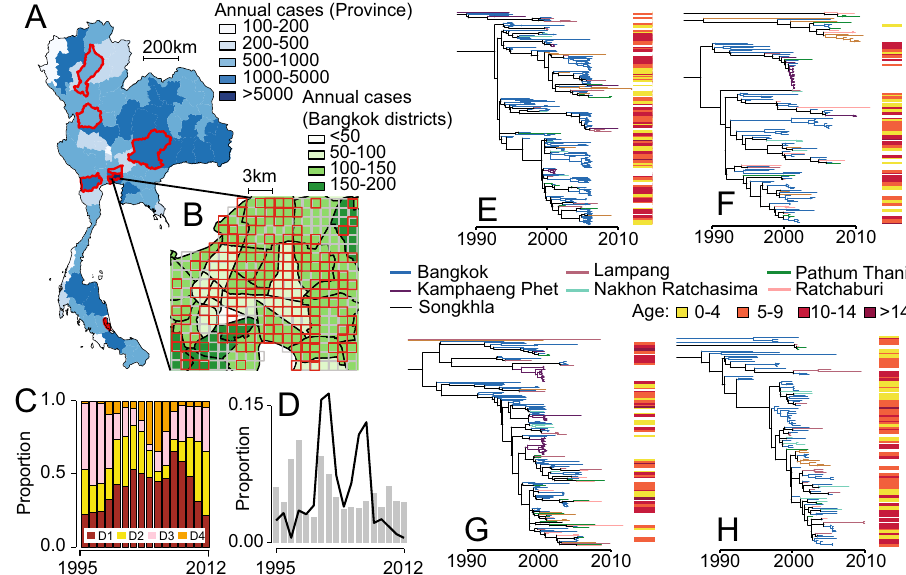
Fig. 1 Dengue sequence and case information. ( A ) Mean annual reported cases per province. The provinces in red represent sentinel sites where sequenced viruses are available. ( B ) Mean annual reported cases per district in central Bangkok. The grid cells in red are locations with available sequences. ( C ) Serotype distribution by year. ( D ) The distribution of all reported cases (grey) and available sequences (black line) from 1995 to 2012 by the year they were reported. Time-resolved phylogenetic trees for ( E ) DENV1, ( F ) DENV2, ( G ) DENV3 and ( H ) DENV4 with location and age